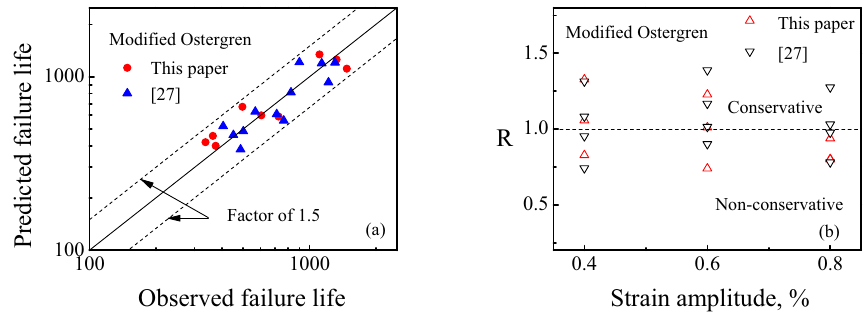
Figure 12: Comparisons between predicted fatigue life and observed fatigue by modi fi ed Ostergren model life under di ff erent loading